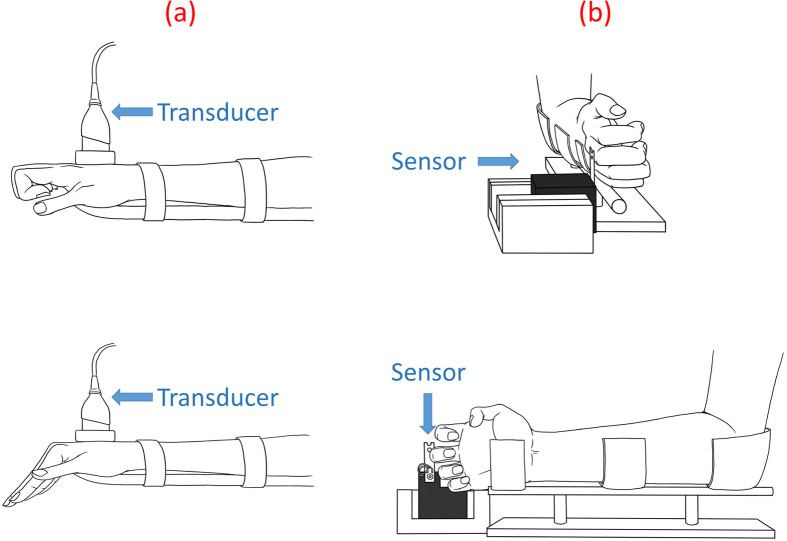
Schematic of a patient’s hand adopting an intrinsic-minus position for extension and intrinsic-plus position for flexion (a), and of a single-digit-force being measured (b).